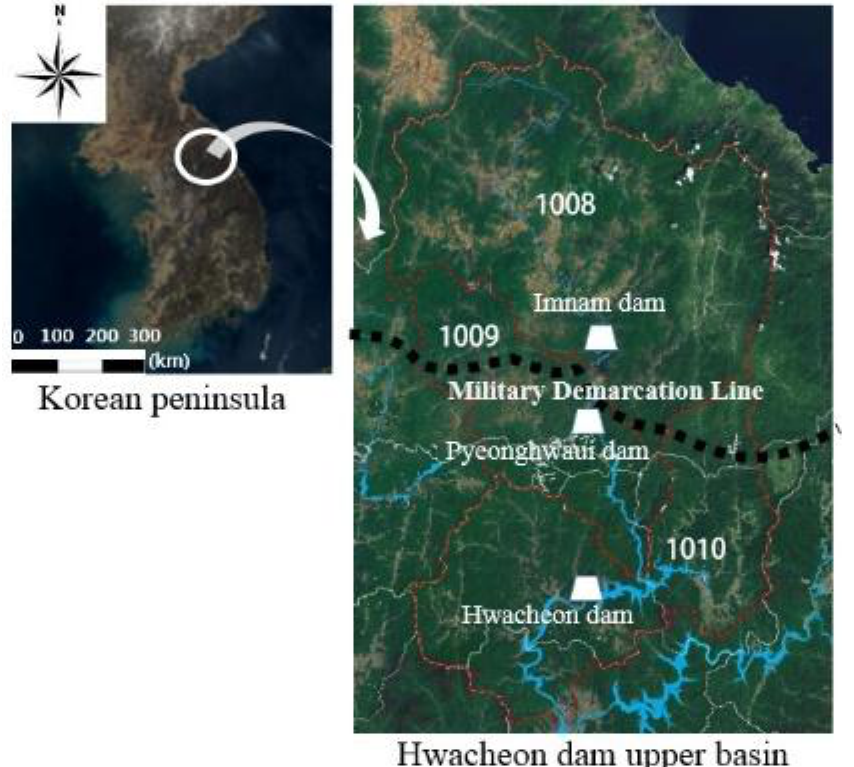
Figure 2. Selected basin and three sub-basins. (Dotted black line: Military demarcation line, Dotted red line: Border line of